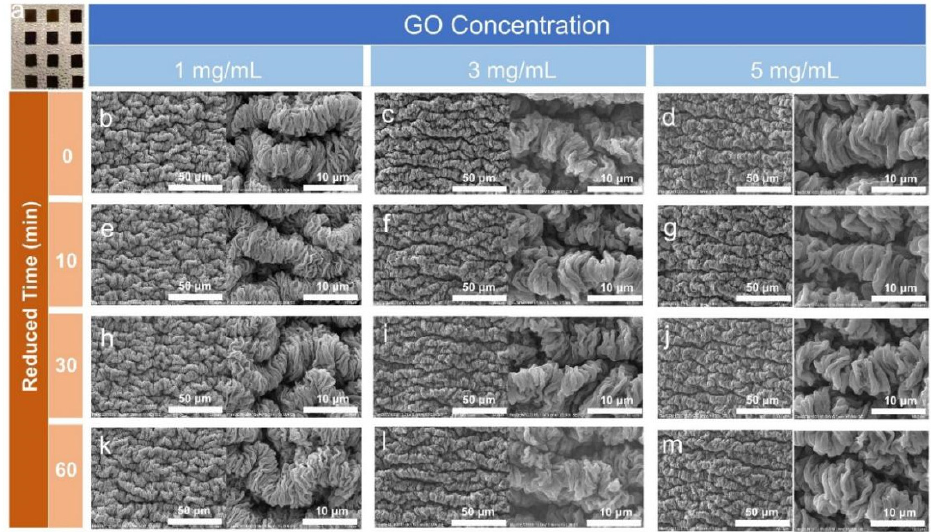
Figure 2. Optical images of ( a ) WG@R and SEM images of WG@R prepared with different concen- trations and different reduction times. ( b ) WGO@R-1, ( c ) WGO@R-2, ( d ) WGO@R-5, ( e ) WG@R-1-10, ( f ) WG@R-2-10, ( g )WG@R-5-10, ( h ) WG@R-1-30, ( i )WG@R-2-30, ( j ) WG@R-5-30, ( k ) WG@R-1-60, ( l ) WG@R-2-60, and ( m ) WG@R-5-60.